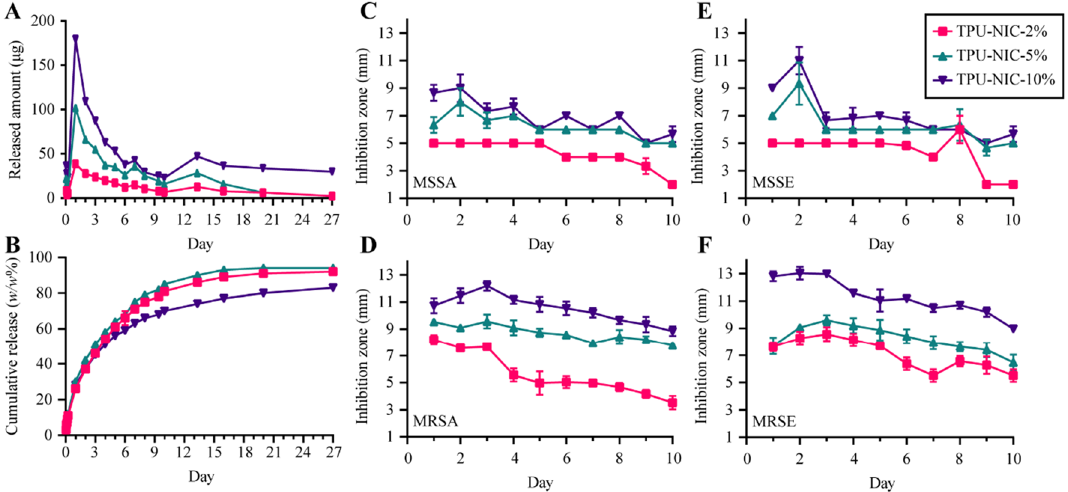
Figure 5. ( A ) Amount of NIC released (in µg) and ( B ) cumulative release (in w/w % of original NIC loading) over time up to 27 days, ZOI diameter (in mm) of ( C ) MSSA, ( D ) MRSA, ( E ) MSSE and ( F ) MRSE around NIC- loaded catheter segments transferred to fresh plates each day for 10 consecutive days ( n =